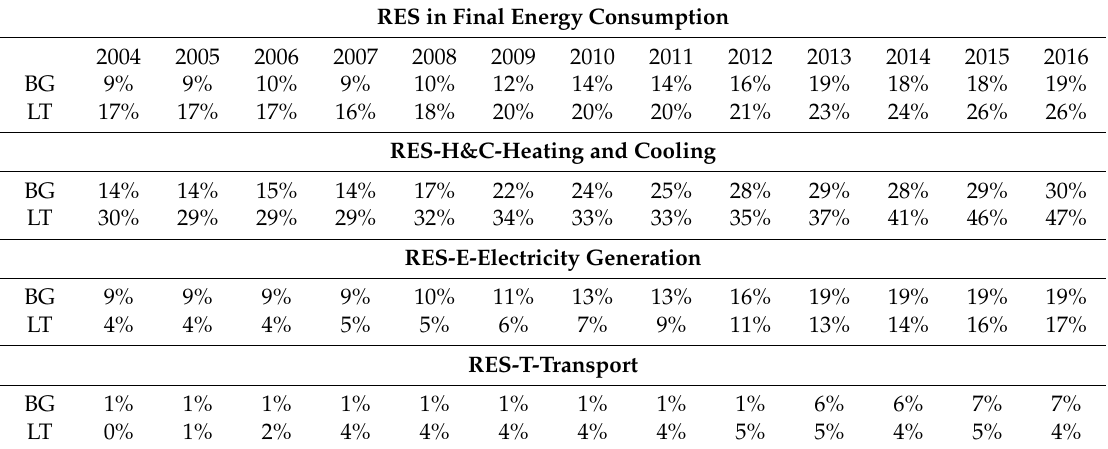
Table 3. The share of renewables in final energy consumption, in electricity, in heating and cooling and transport in Lithuania and Bulgaria, %. Source: